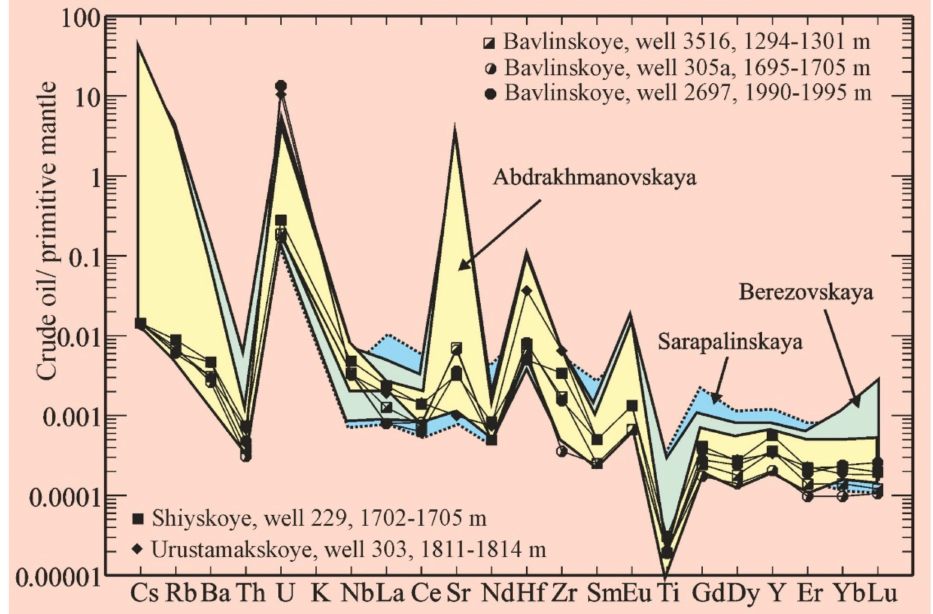
Figure 5. Spider diagram normalized by the primitive mantle composition [18] for crude oil of